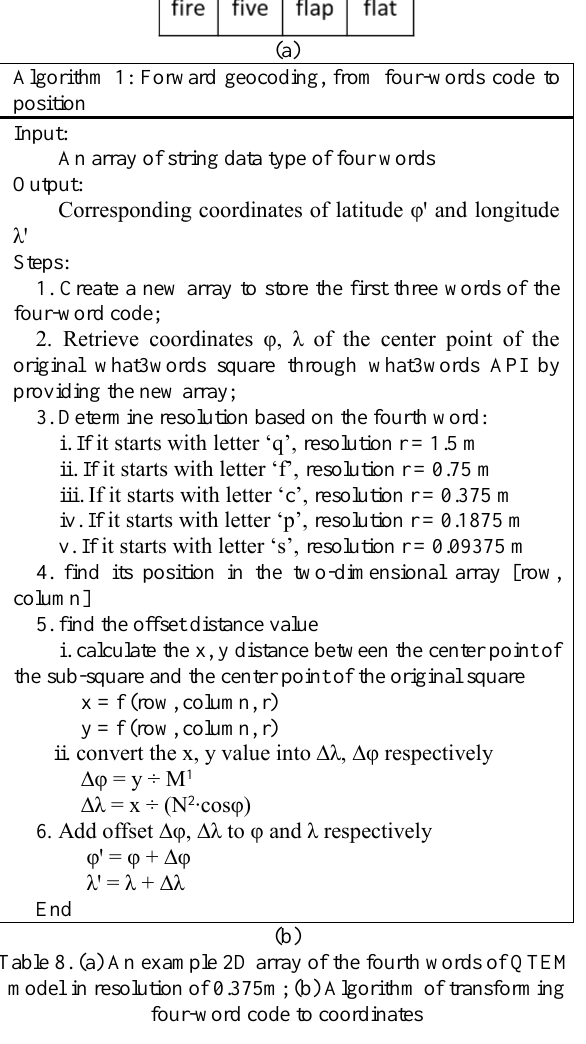
Table 8. (a) An example 2D array of the fourth words of QTEM model in resolution of 0.375m; (b) Algorithm of transforming four-word code to coordinates